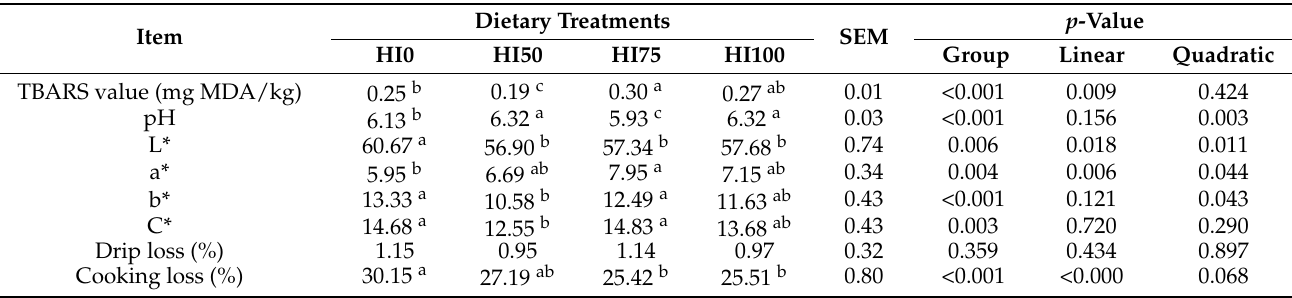
Table 6. TBARS value and the physiochemical properties of breast muscles in broiler chickens fed diets with different levels of full-fat Hermetia illucens (HI) larvae meal (arithmetic mean ±